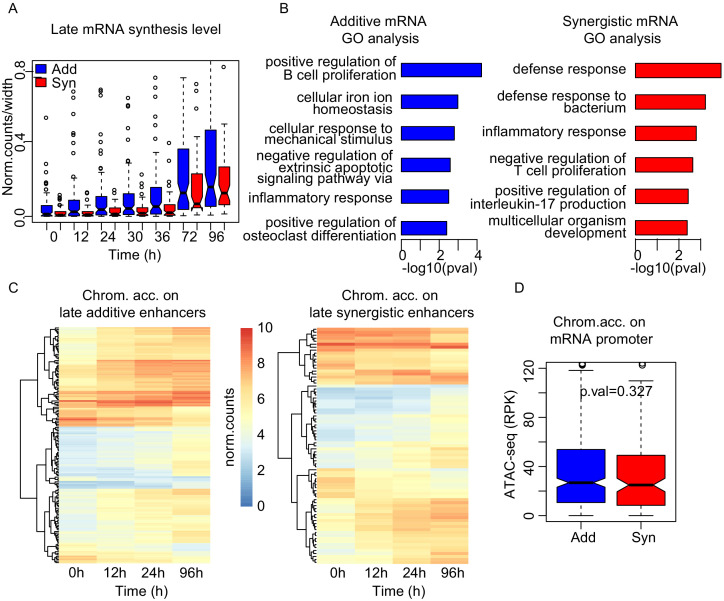
Synergistic enhancers drive cell type-specific genes.(A) mRNA synthesis of the upregulated genes at 96 hr in additive (blue) or synergistic (red) manner. (B) GO analysis of mRNAs regulated in additive (blue) or synergistic (red) manner. (C) Heatmap of chromatin accessibility on additive (left) or synergistic (right) enhancers upregulating the genes at 96 hr. (D) Chromatin accessibility at promoters at 0 hr was not significantly different between additive and synergistic genes in late cluster.